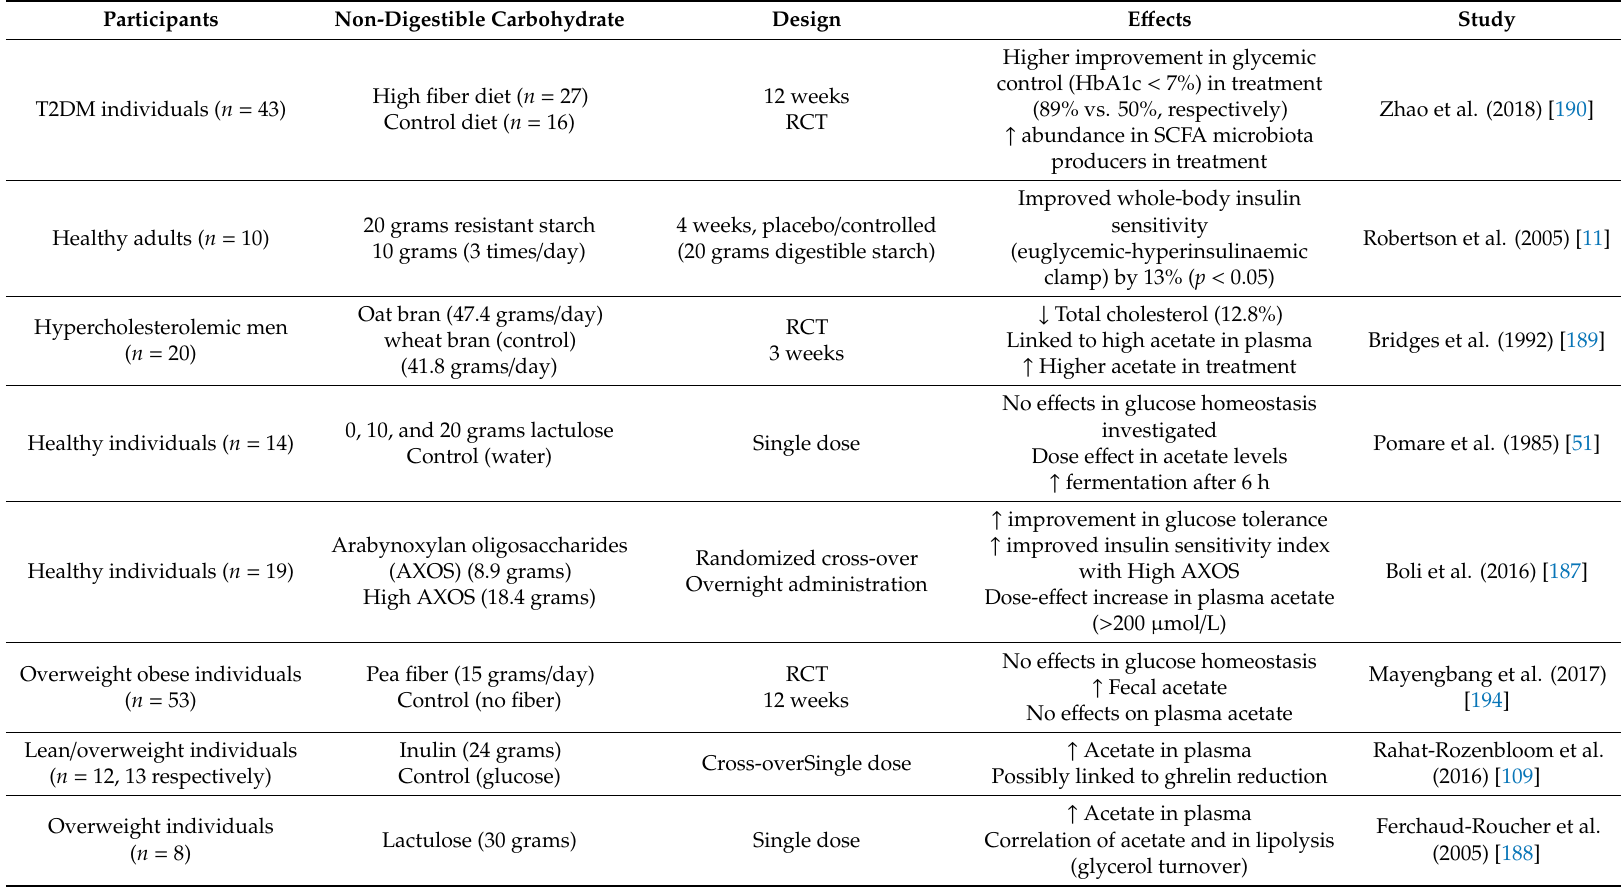
Table 4. Acetogenic fiber administrations with e ff ects on glucose homeostasis and metabolic